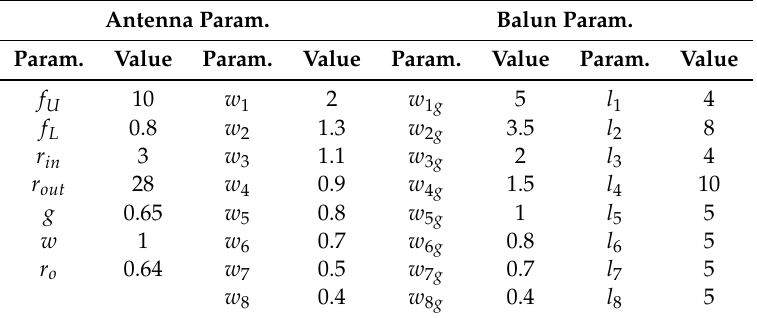
Table 1. Spiral antenna